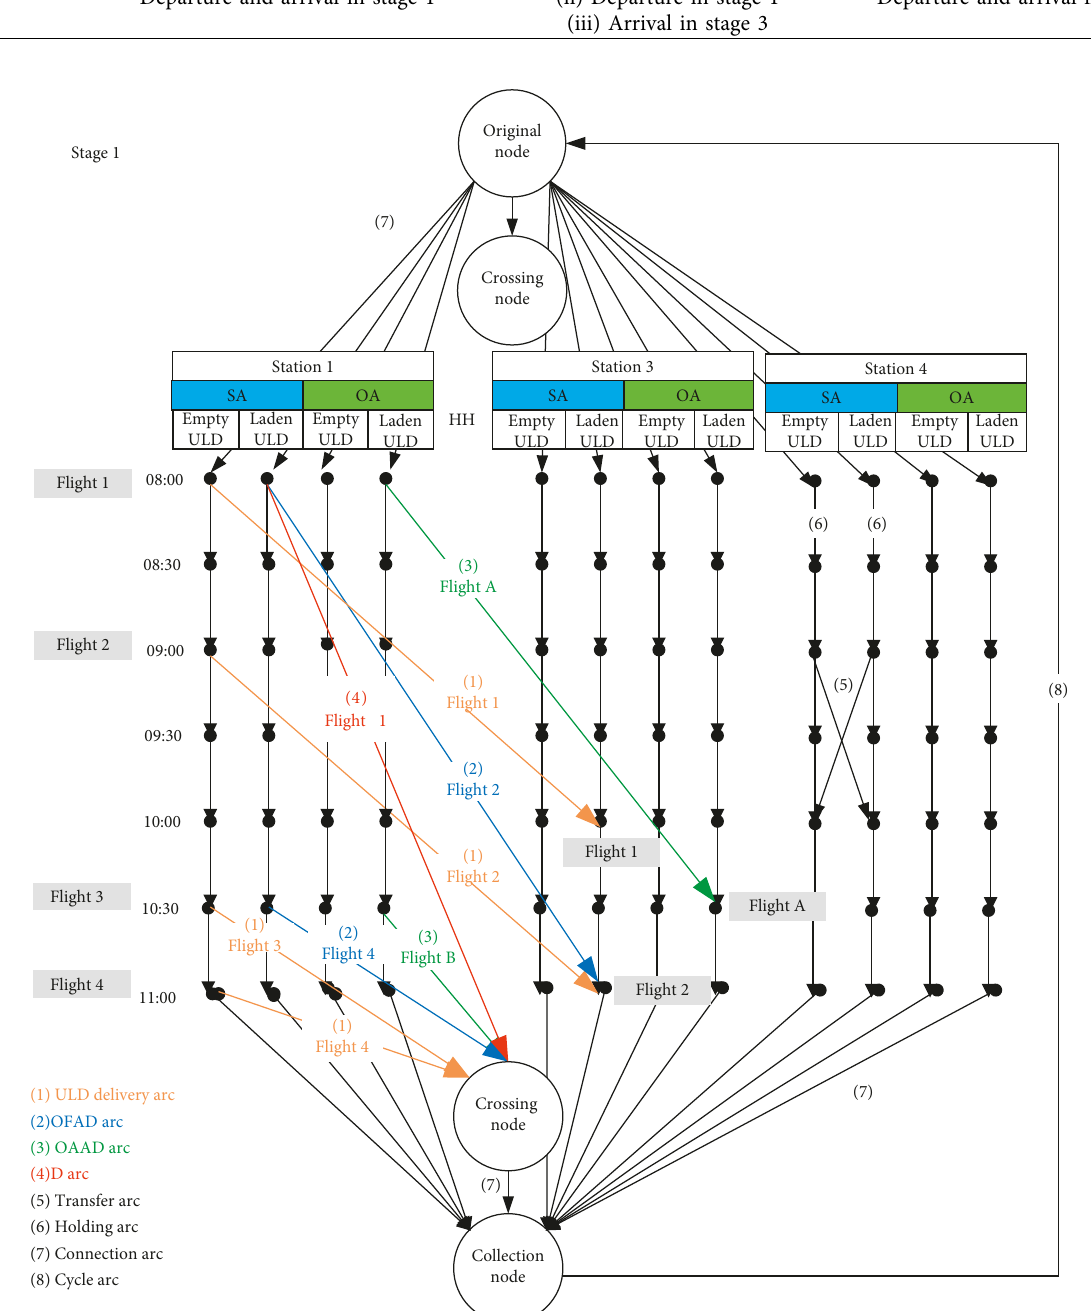
Figure 7: Self-owned ULD network for stage